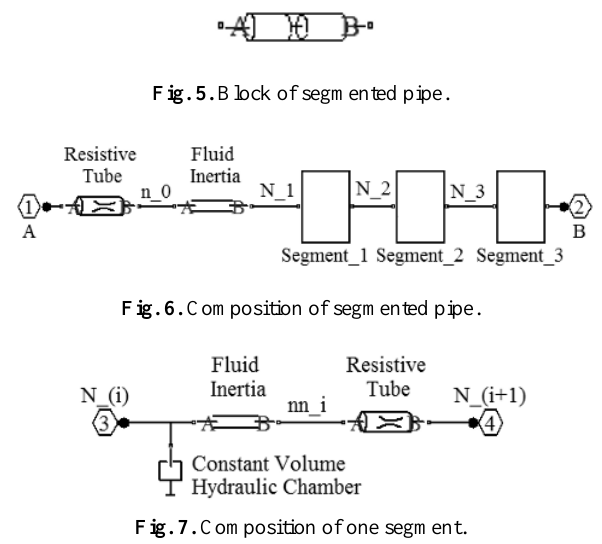
Fig. 5. Block of segmented pipe .